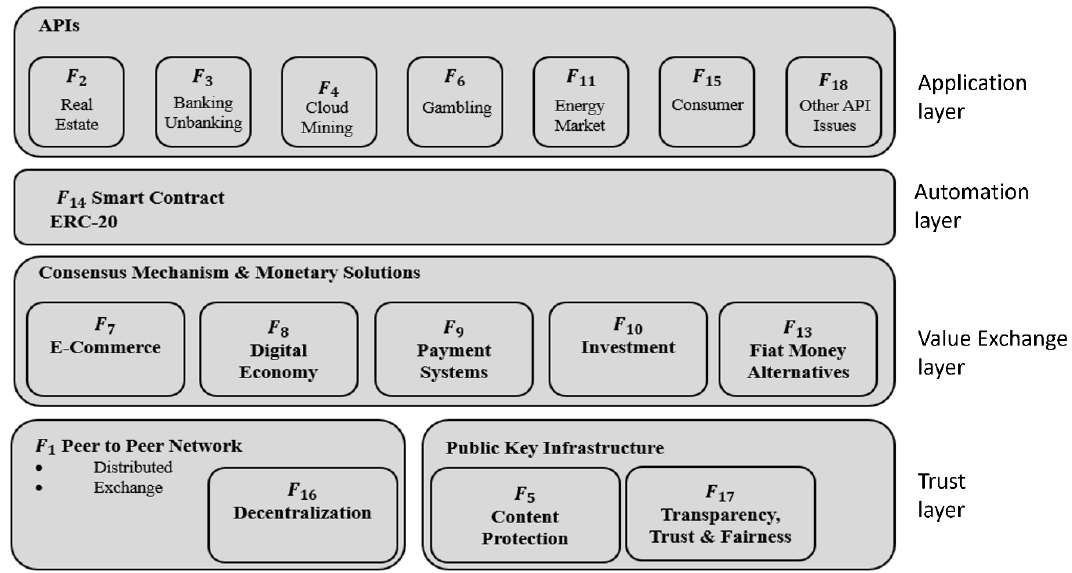
Figure 4. A Stacked layer model of the ICO